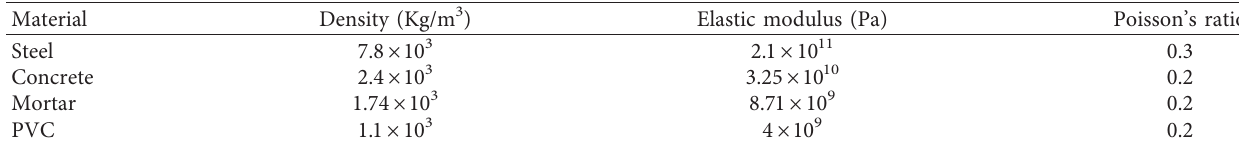
Table 2: Summary of working condition model